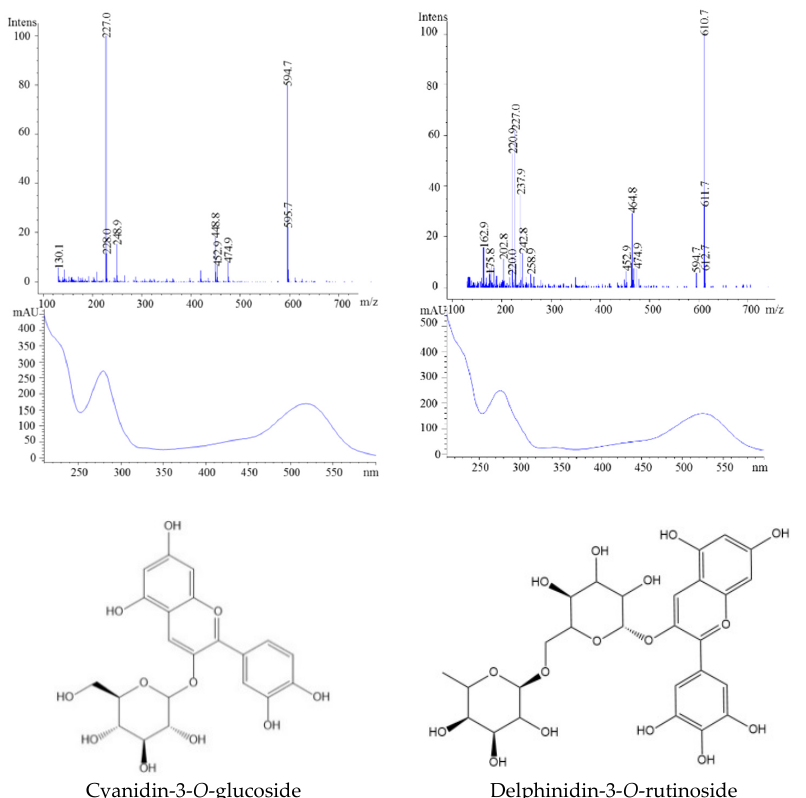
Cyanidin-3- O -glucoside Figure 11. HPLC-MS spectra, UV/vis scanning spectra, and the chemical structures of peaks 17 and 18.